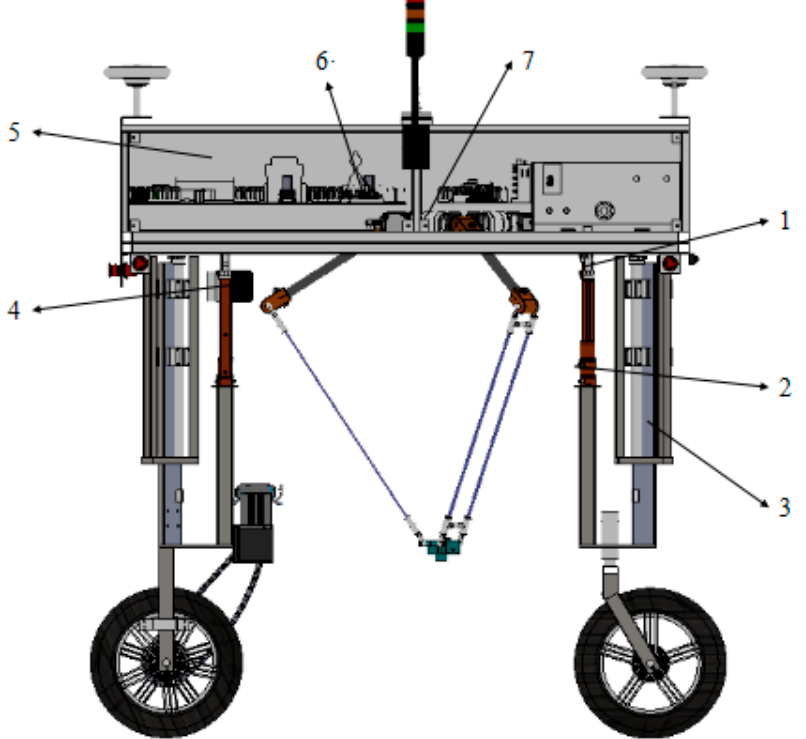
Figure 1. The overall framework of the mobile platform: (1) Pressure sensor, (2) Linear actuator, (3) Levelling outrigger, (4) Displacement sensor, (5) Levelling platform, (6) Microcontroller and other control devices, and (7) IMU.